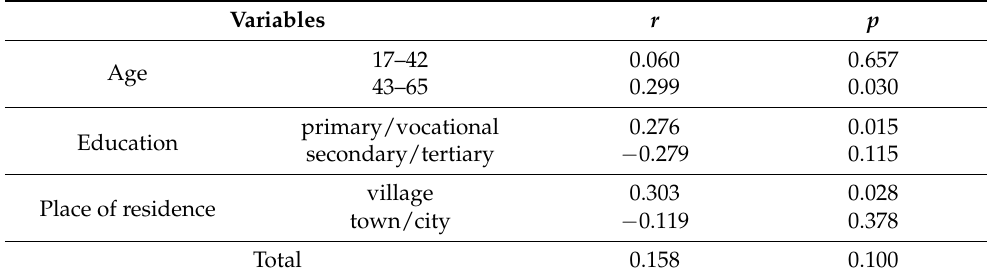
Table 3. Correlation coefficients between the sense of coherence and the intensity of pro-health behaviors. Variables